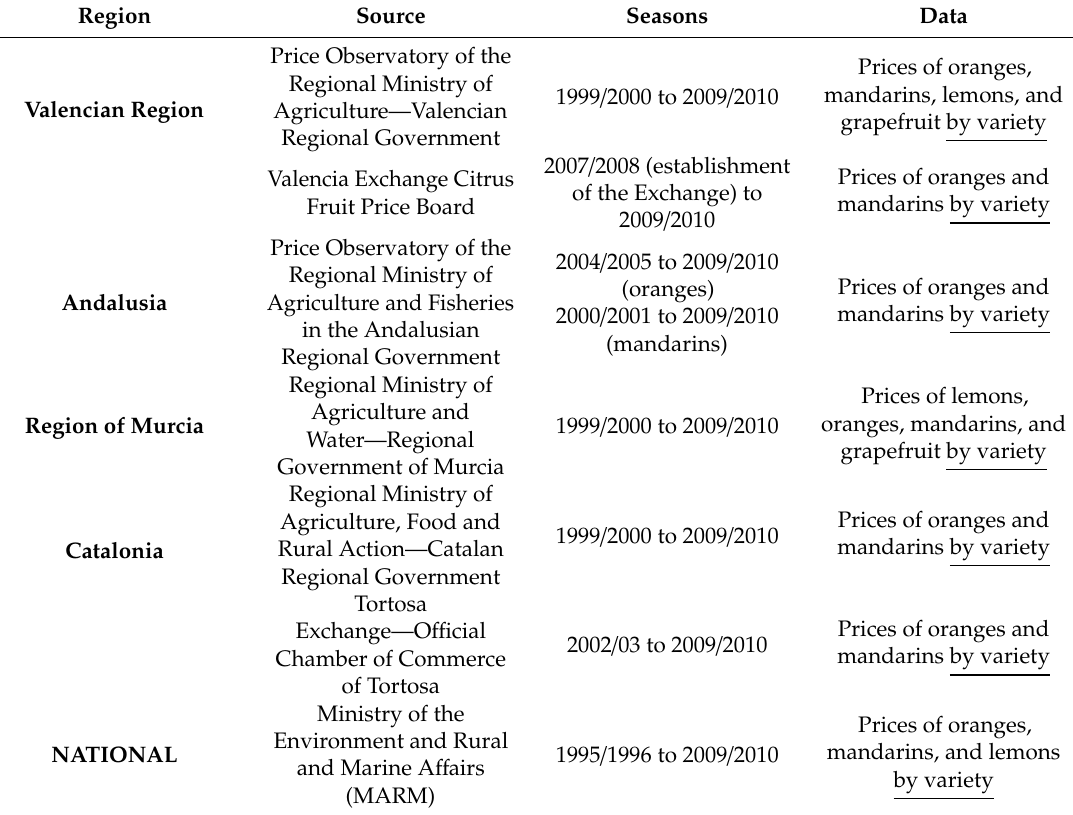
Table 1. Information and sources of citrus fruit field